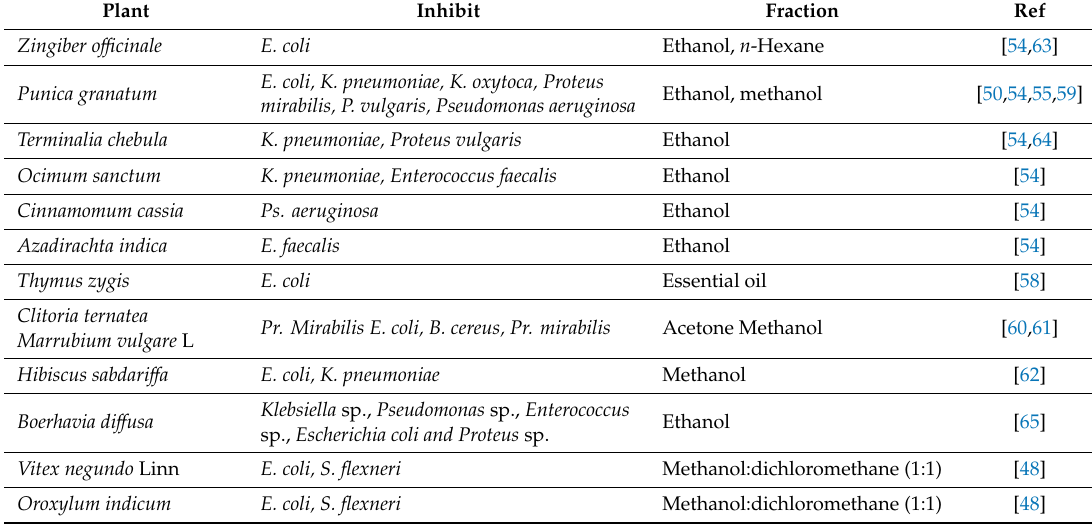
Table 3. Plants active against